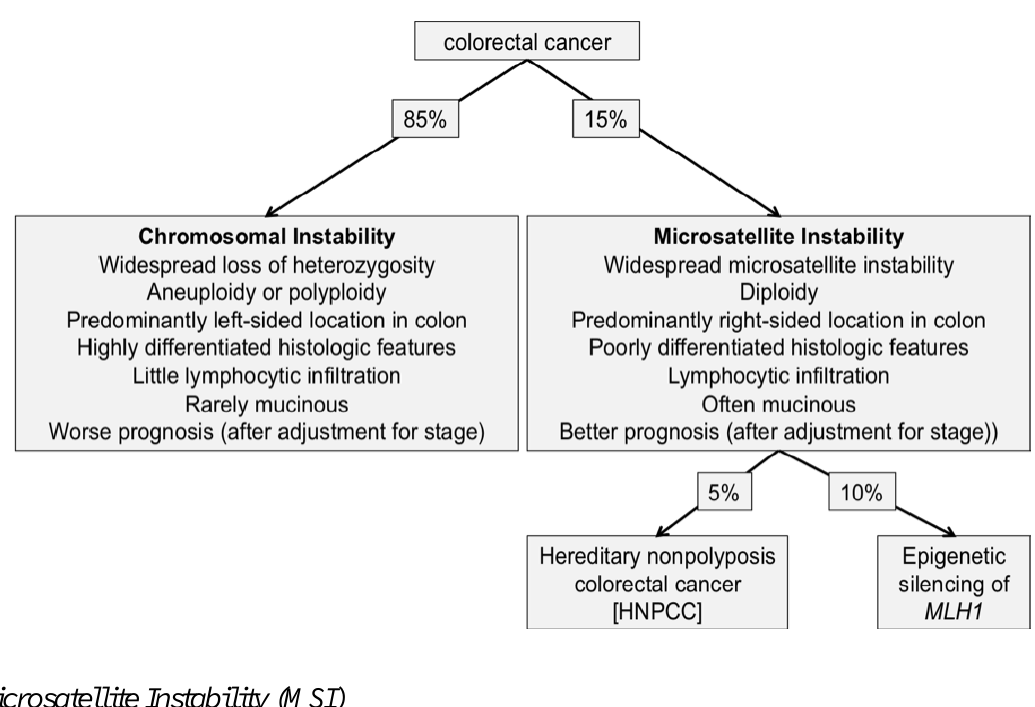
Figure 2 The two genetic pathways of colorectal cancer (modified from de la Chapelle, NEJM 2003